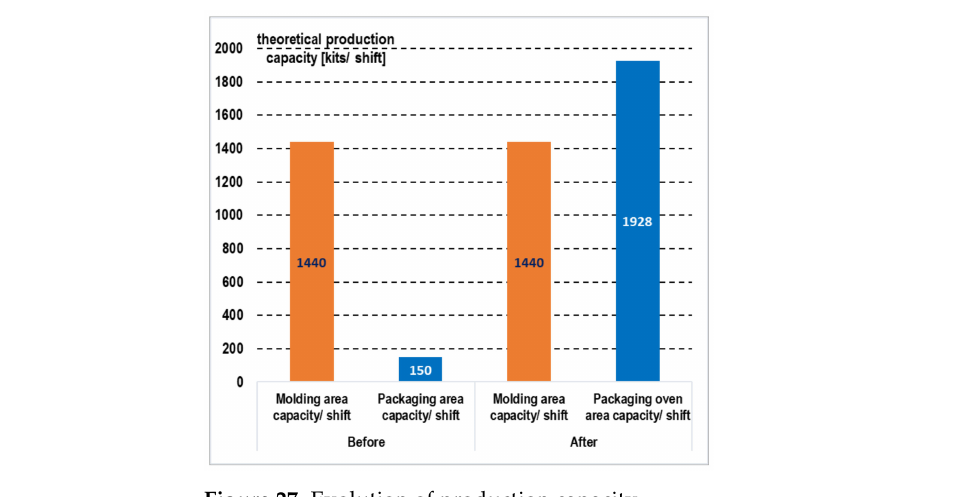
Figure 27. Evolution of production capacity.